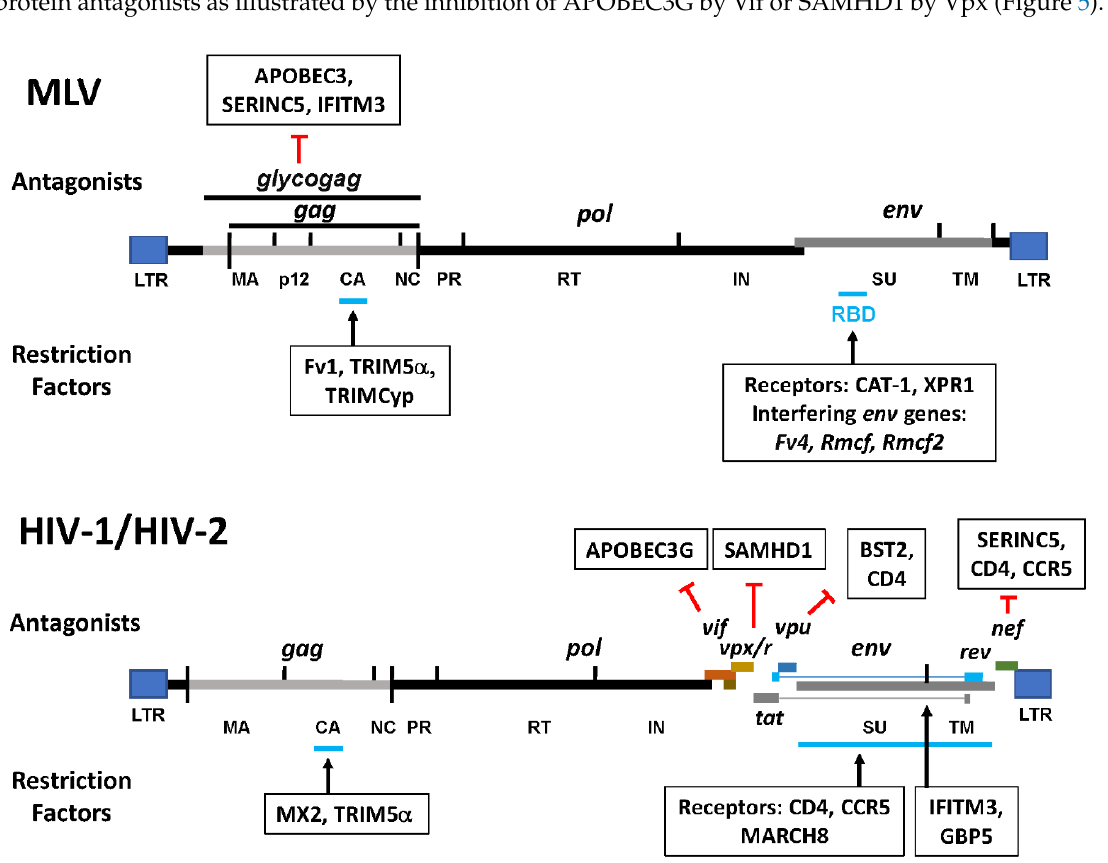
Figure 5. Retroviral targets and virus-encoded antagonists of restriction factors. Viral antagonists and the restriction factors they target are indicated above each schematically represented MLV and HIV-1 genome. Restriction factors and their known viral protein targets are shown below each genome.